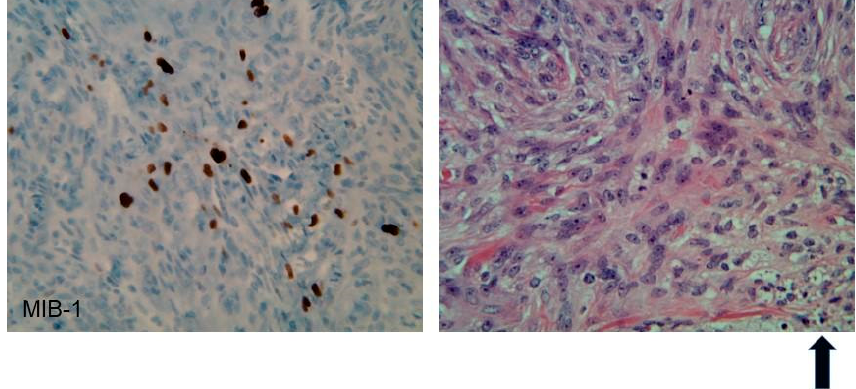
Figure 2. Immunohistochemistry of an atypical meningioma (WHO Grade II) from an NF2 patient. Left panel: 40 × magnification, MIB-1(Ki67) nuclear immunostain shows an elevated index (25%). Right panel: 40 × H&E shows increased cellularity, prominent nucleoli, mitoses, and necrosis (as represented in the bottom right hand section and highlighted by the arrow in bold).